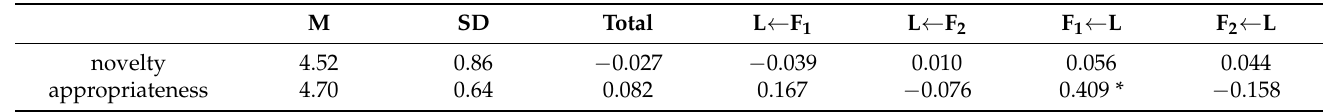
Table 5. Correlation between the frequency of turns of the elected leader and the indicators of group